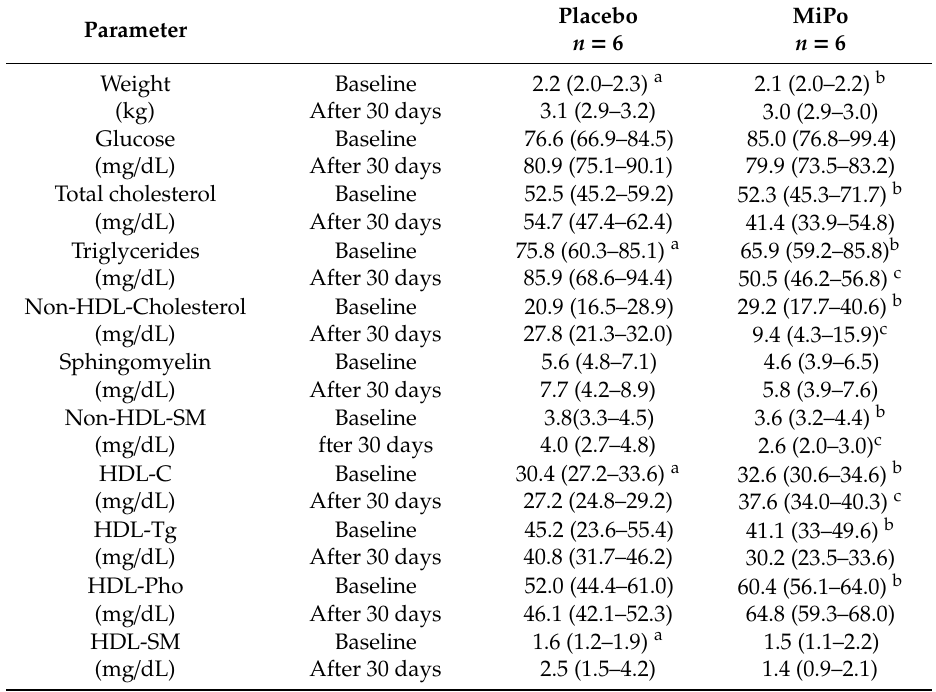
Table 1. Blood glucose levels, weight, lipid profile, and sphingomyelin before and after intervention with microencapsulated pomegranate (MiPo) or placebo